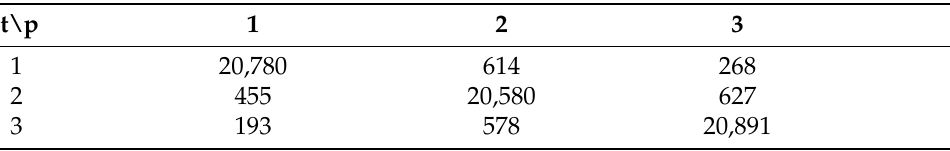
Table 9. The confusion matrix of the TUG model. The class with the least false classifications is 1 and the class with the most false classifications is 3. t = true label, p = predicted